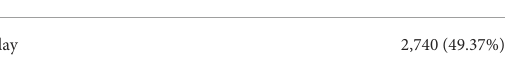
TABLE 1A Percentage of subjects with last recorded dose ≤ or > to 80 mg/day. Last recorded dose